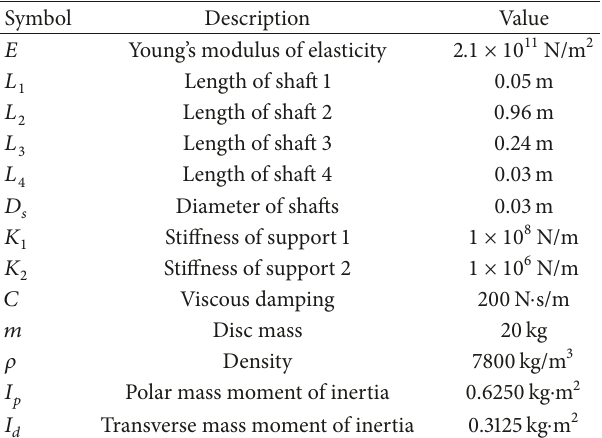
Table 1: Parameters of the rotor